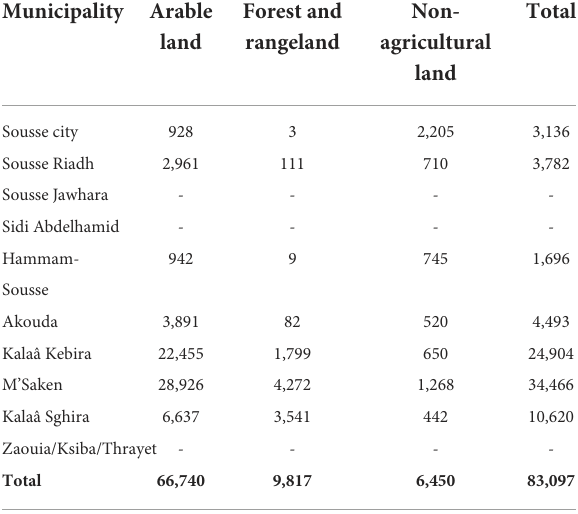
TABLE 1 Distribution of land uses by type and municipality in “Grand Sousse”